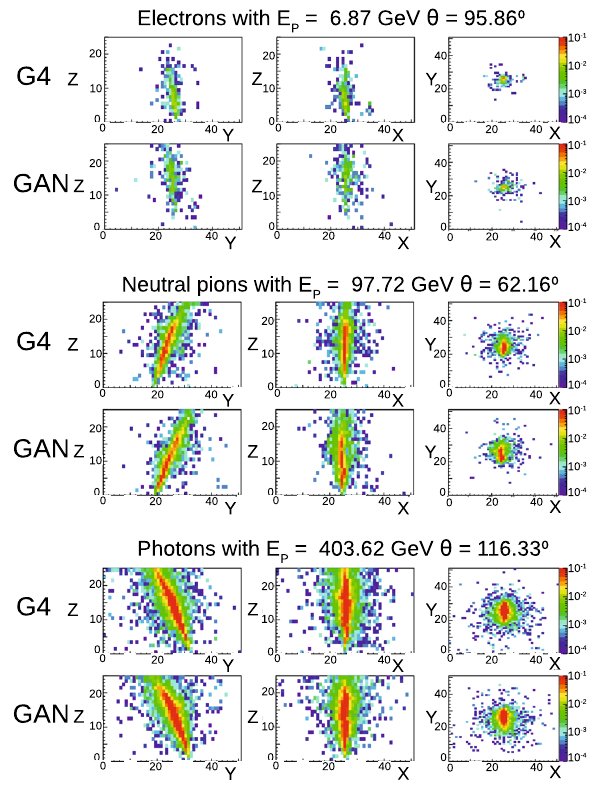
Fig. 7 Projections of Monte Carlo vs. GAN events on the YZ, XZ and XY planes. (Top) Electron with E P = 6 . 87 GeV and θ = 95 . 86 ◦ . (Mid) neutral pions with E P = 97 . 72 GeV and θ = 62 . 16 ◦ . (Bottom) photons with E P = 403 . 62 GeV and θ = 116 . 33